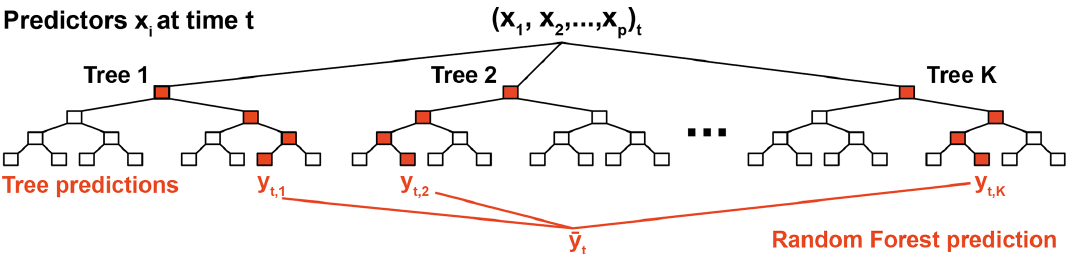
Figure 3. Sketch of a random forest regressor. Each random forest consists of an ensemble of K trees. For visualization purposes, the trees shown here have only four levels of equal depth, but more complex structures can be learnt. The lowest level contains the leaf nodes. Note that in real examples, branches can have different depths; i.e. the leaf nodes can occur at different levels of the tree hierarchy; see, for example, Fig. 2 in Zimmerman et al. (2018). Once the decision rules for each node and tree are learnt from training data, each tree can be presented with new sensor readings x at a time t to predict pollutant concentration y t . The decision rules depend, inter alia, on the tree structure and random sampling through bootstrapping, which we optimize through fivefold cross-validation. Based on the values x i , each set of predictors follows routes through the trees. The training samples collected in the corresponding leaf node define the tree-specific prediction for y . By averaging K tree-wise predictions, we combat tree-specific overfitting and finally obtain a more regularized random forest prediction y t .